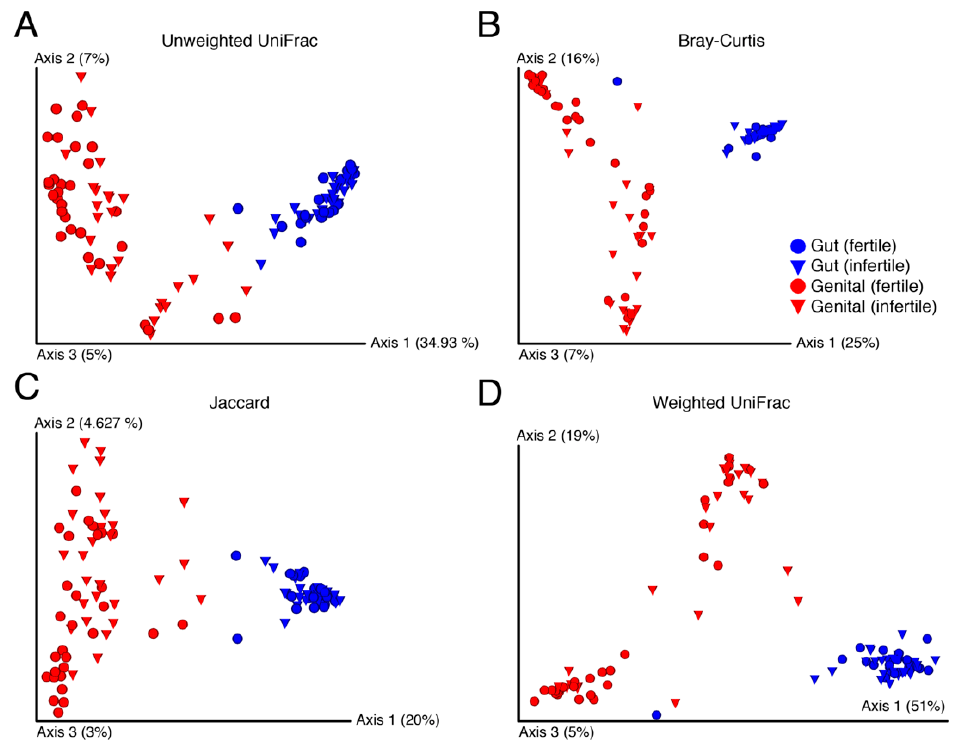
Figure 3. Principal coordinates highlight dissimilarity between samples evaluated by standard beta-diversity indicators (( A – D ), Unweighted UniFrac, Bray-Curtis, Jaccard, and Weighted UniFrace, respectively). Numbers in parentheses indicate percentage variability (%) explained by each axis. Table 4. Differences in the beta-diversity among samples, as evaluated by pairwise PERMONVA with 999 permutations. (<0.1 are in